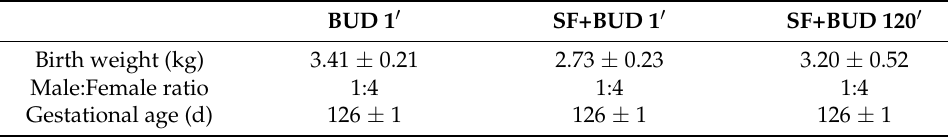
Table 1. Characteristics of the lambs included in this